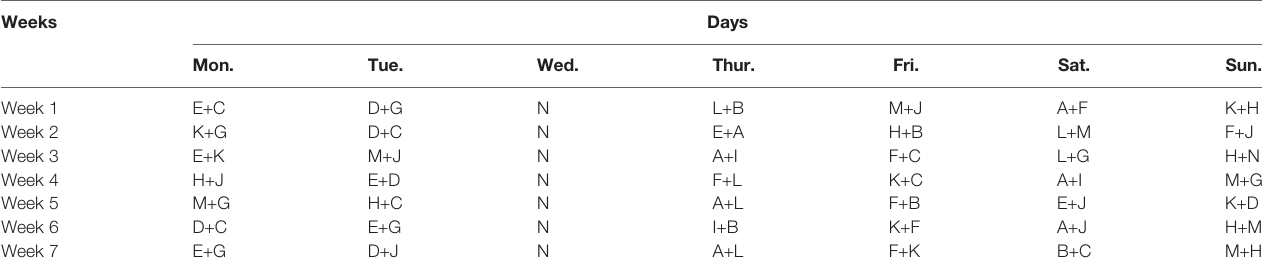
TABLE 1 | The schedule of CUMS stressors.